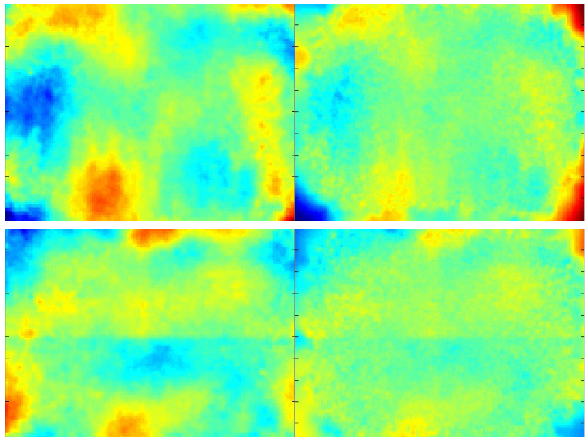
Figure 11. The theoretical simulation: sensor unflatness in x (upper part) and y (lower part) coordinates. Left – simulated sensor unflatness – ground truth, right – computed unflatness. The results are based on the green channel. Scale: – 1.5 to 1.5